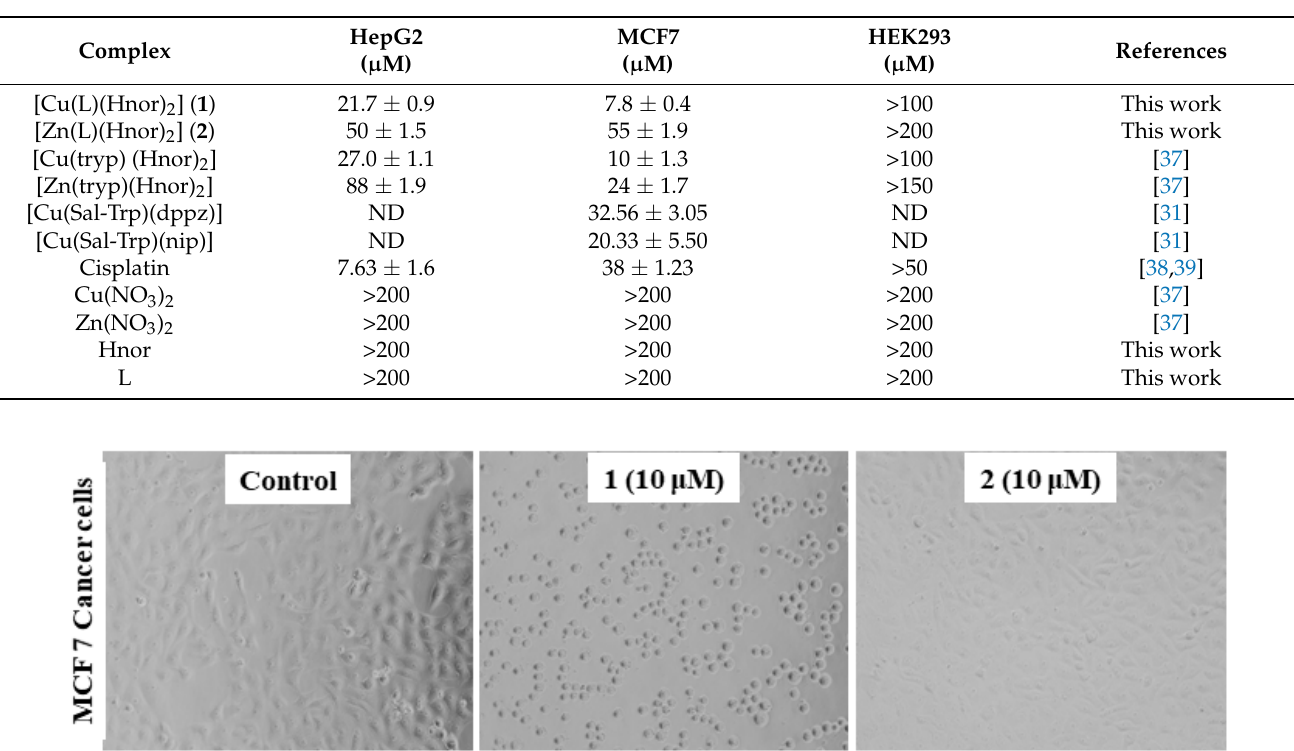
Table 3. Cell viability assay (MTT assay) gives the IC 50 values ( µ M) to treat two human cancer cell lines (HepG2 and MCF7) and a non-tumorigenic cell (HEK293).